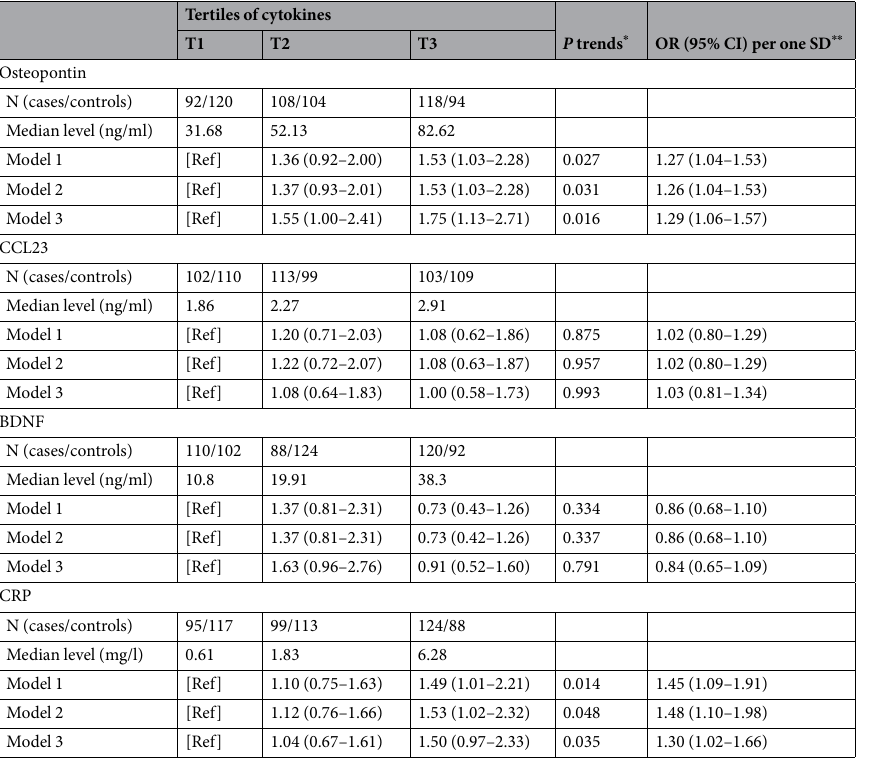
Table 3. Adjusted Odds Ratio for Risk of ACS According to Four Replicated Plasma Cytokines in Nested Case-control Study. Plasma cytokine levels were ln-transformed prior to analysis. Model 1: Adjusted for age (continuous). Model 2: Additionally, adjusted for BMI (continuous) and smoking status (current, former and never). Model 3: Additionally, adjusted for total cholesterol (continuous), low-density lipoprotein cholesterol (continuous), triglycerides (continuous), fasting glucose (continuous), estimated glomerular filtration rate (continuous), systolic blood pressure (continuous), anti-hypertensive medication (binary), and lipid-lowing medication (binary). * P values when we assigned the median value to each group and used this as a continuous variable in linear regression models. ** OR for each SD